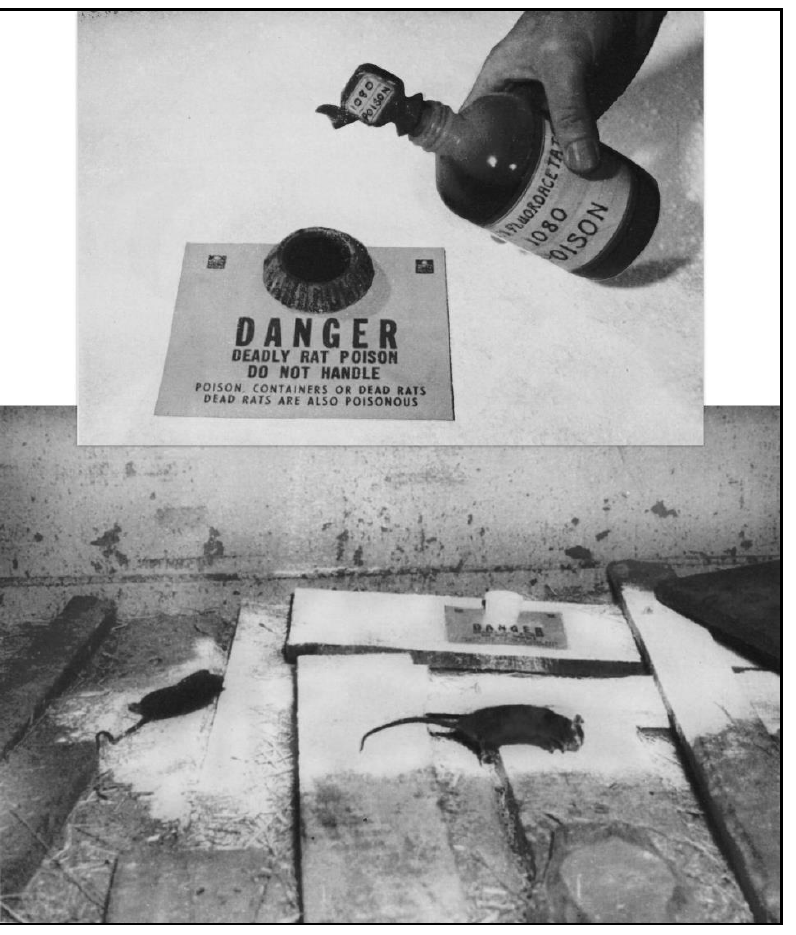
Figure 4. Above: Compound 1080 bait station. Below: Rats in a ship’s hold killed by 1080 (the white powder is dichlorodiphenyltrichloroethane (DDT) dust) [53].